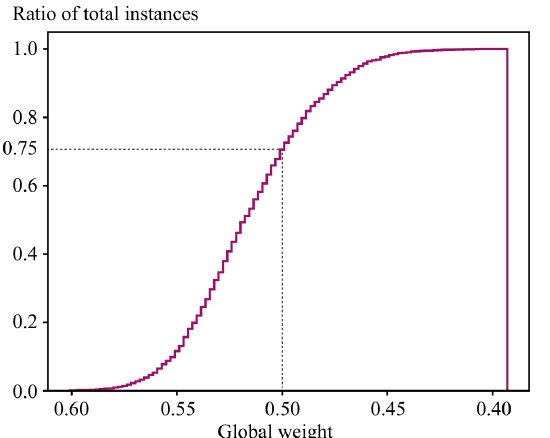
Figure 4. Accumulative step histogram of the weights of the global visual features used in similar- ity aggregation.